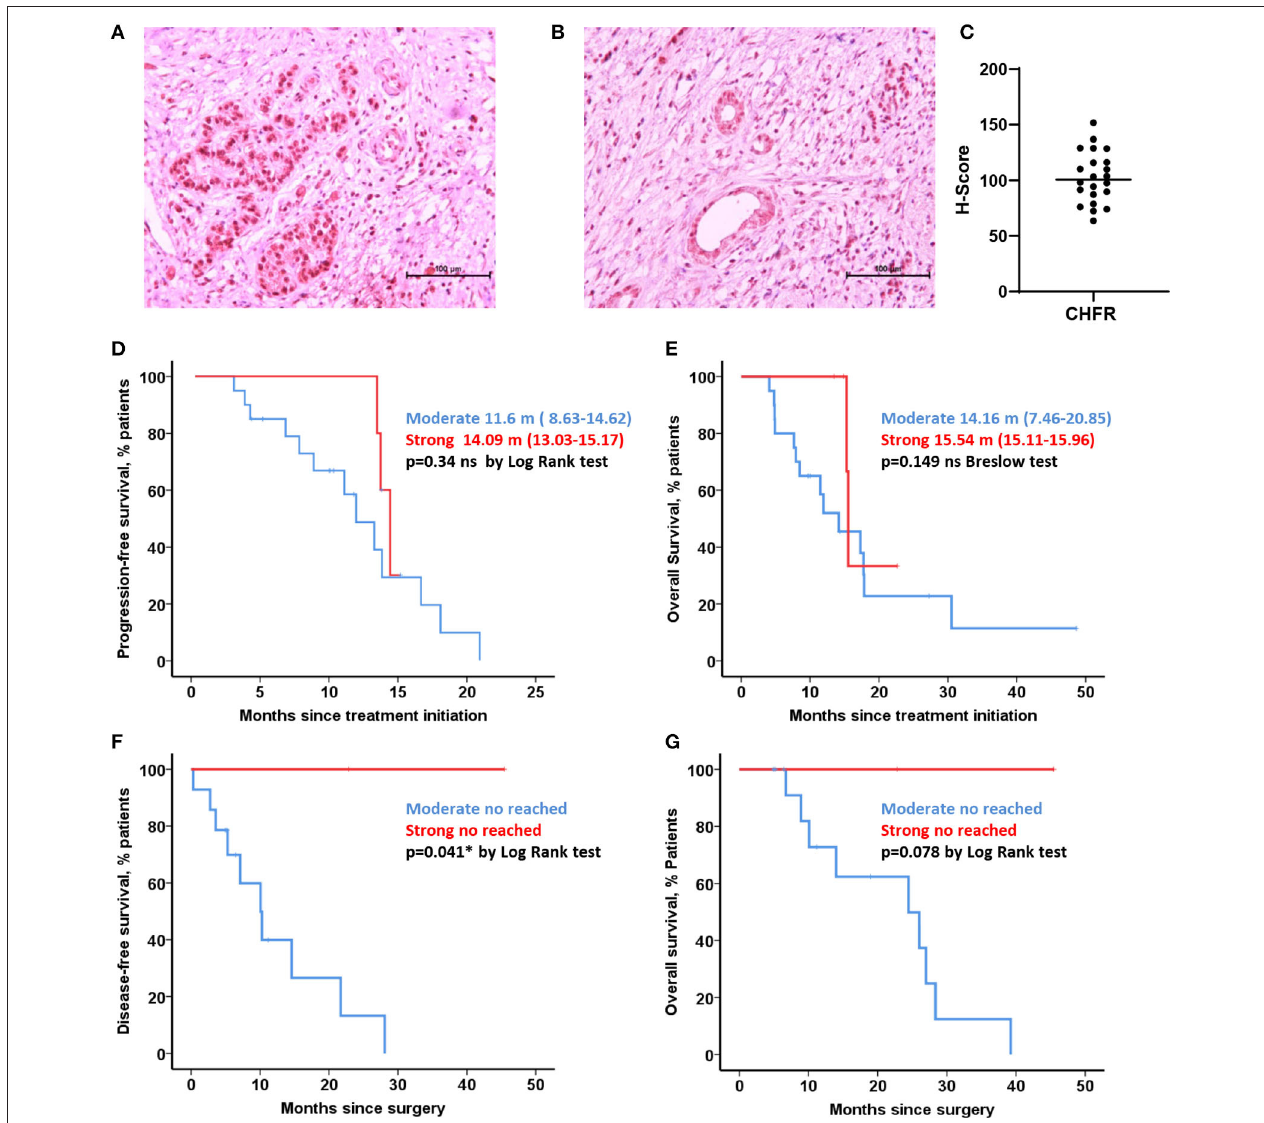
FIGURE 1 | CHFR expression analysis. IHC pictures with differential expression, strong and weak stain (A,B) H-Score values from quantitative analysis performed in QuPath software with differential expression of CHFR (C) . Kaplan-Meier curves representing progression-free survival and overall survival for borderline cohort (15 patients with moderate stain vs. 4 strong stain) (D,E) . Kaplan-Meier curves representing disease-free survival and overall survival for resectable cohort (14 patients with moderate stain vs. 2 strong stain) ( F,G , respectively). *Statistically significant differences ( p < 0.05) and ns no significant differences ( p >